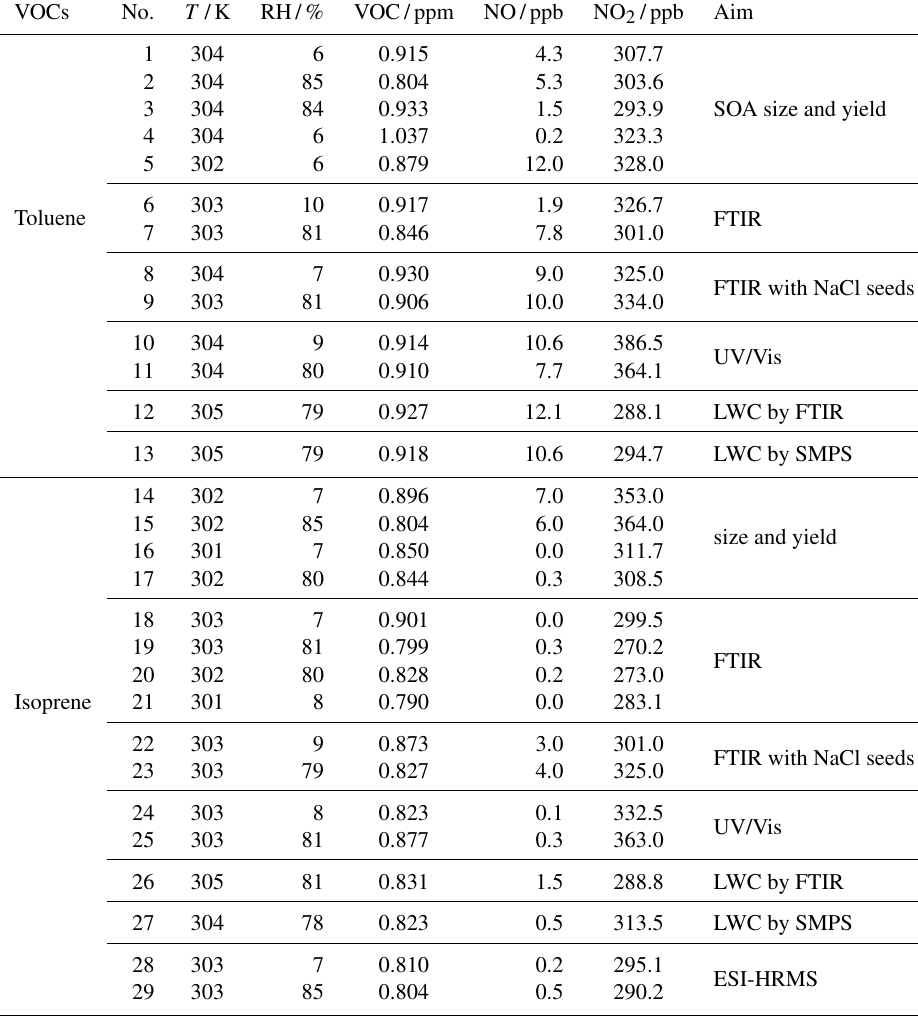
Table 1. Experimental conditions of toluene and isoprene